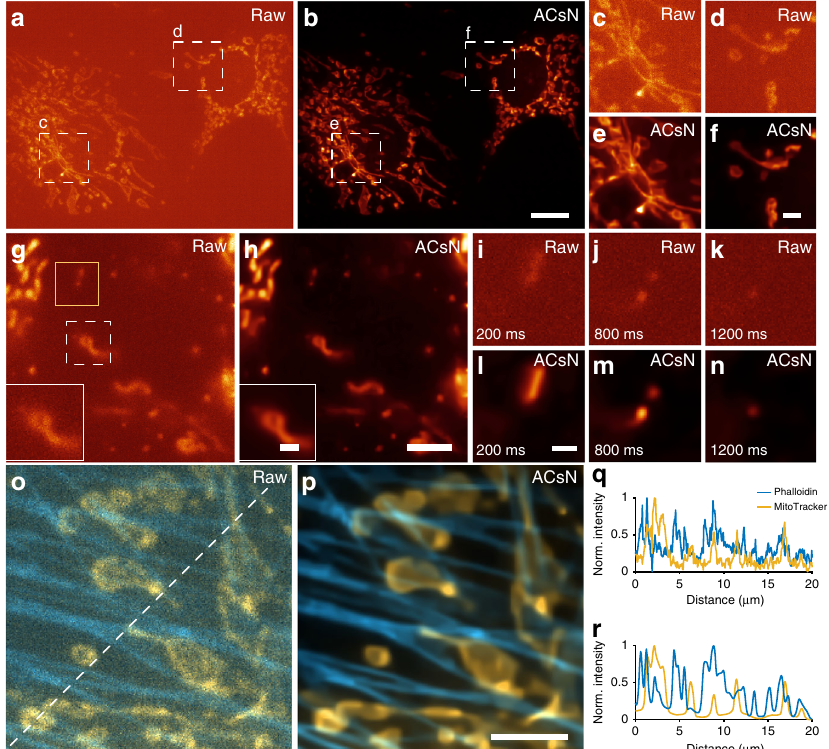
Fig. 2 ACsN noise correction improves wide- fi eld fl uorescence microscopy. a Epi- fl uorescence imaging of mitochondria in fi xed bovine pulmonary artery endothelial (BPAE) cells at an exposure time of 1 ms. b The same image in a after ACsN denoising. c – f Zoomed-in images of the corresponding boxed regions in a and b . Quantitative results and analysis are reported in Supplementary Table 1. g Representative frame from a time-lapse of 100 images of mitochondria in live human embryonic kidney (HEK) cells recorded at 50 Hz (exposure time: 20 ms). h The corresponding representative frame of the image sequence ( g ) obtained after ACsN processing. The insets in g and h show zoomed-in images of the corresponding regions marked in the dashed white box in g . i – n Zoomed-in images of the corresponding regions marked in the solid yellow box in g at different time points of 200 ms ( i , l ), 800 ms ( j , m ), and 1200 ms ( k , n ). o , p Dual-color image, respectively, before ( o ) and after ( p ) ACsN denoising of F-actin (cyan) and mitochondria (orange) in fi xed BPAE cells obtained by TIRF microscopy with an exposure time of 2 ms. q , r Cross-sectional intensity pro fi les of ( o ) and ( p ) along the corresponding dashed line in o , respectively, showing substantially denoised and better resolved cellular structures. Scale bars: 10 μ m ( b ), 3 μ m ( f ), 4 μ m ( h , p ), 1 μ m ( h , inset) and ( l